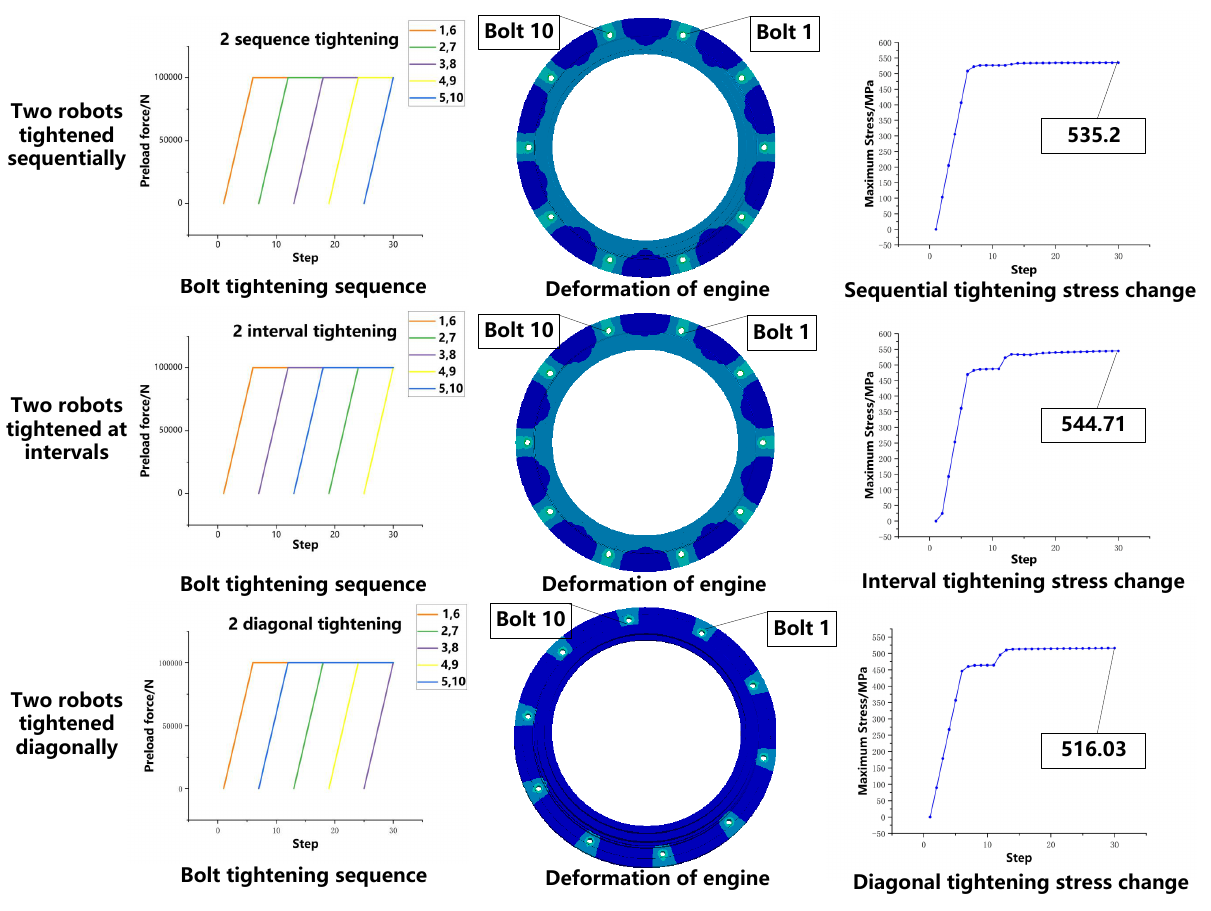
Figure 13. Deformation and stress of engine cabin section when two robots are used to tighten.